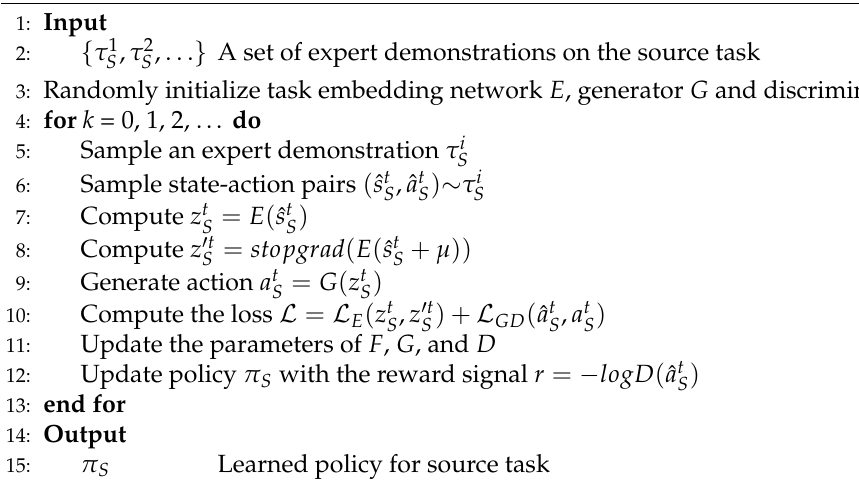
Algorithm 1 Training the proposed agent on the source